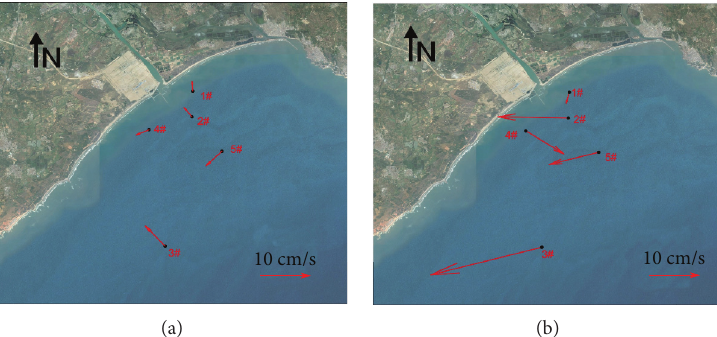
Figure 7: The residual current vector diagram of the study sea region, the velocity vectors indicate the depth average velocity. (a) The residual current of the spring tide; (b) the residual current of the neap